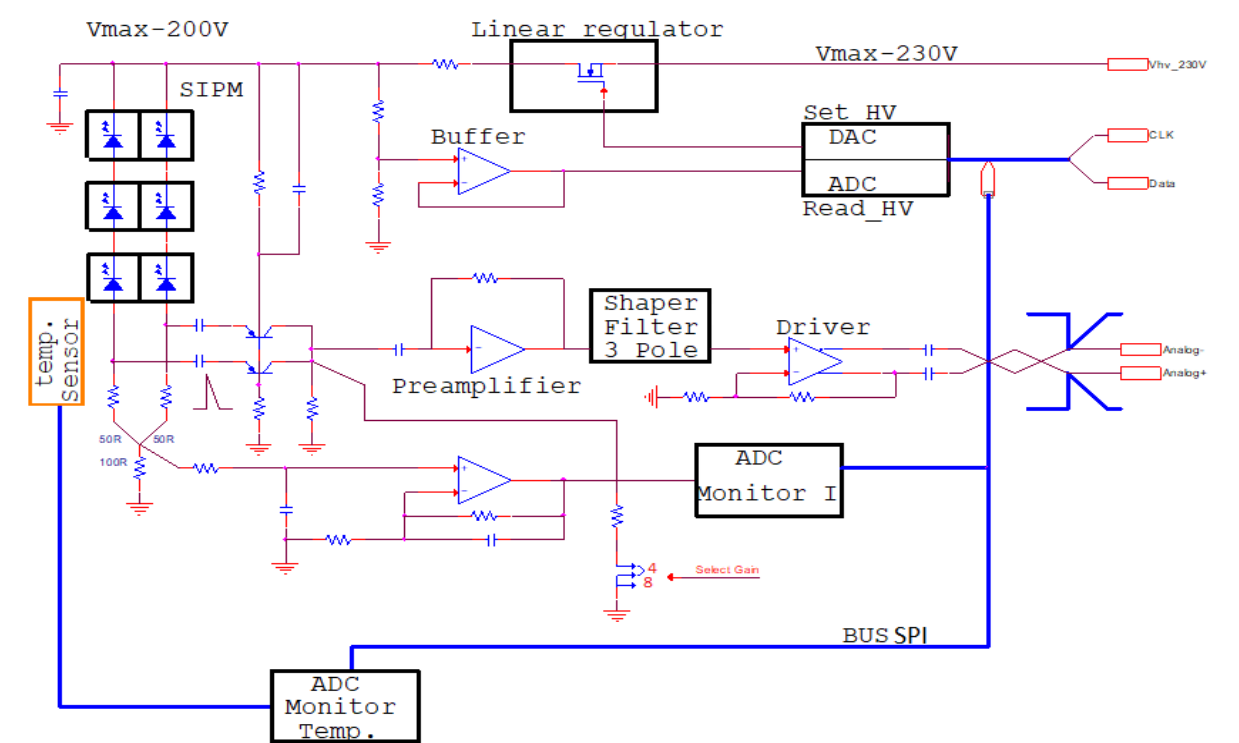
Figure 3. Block schematic of the FEE board architecture. The signal amplification and shaping, along with the integrated slow control functions, are